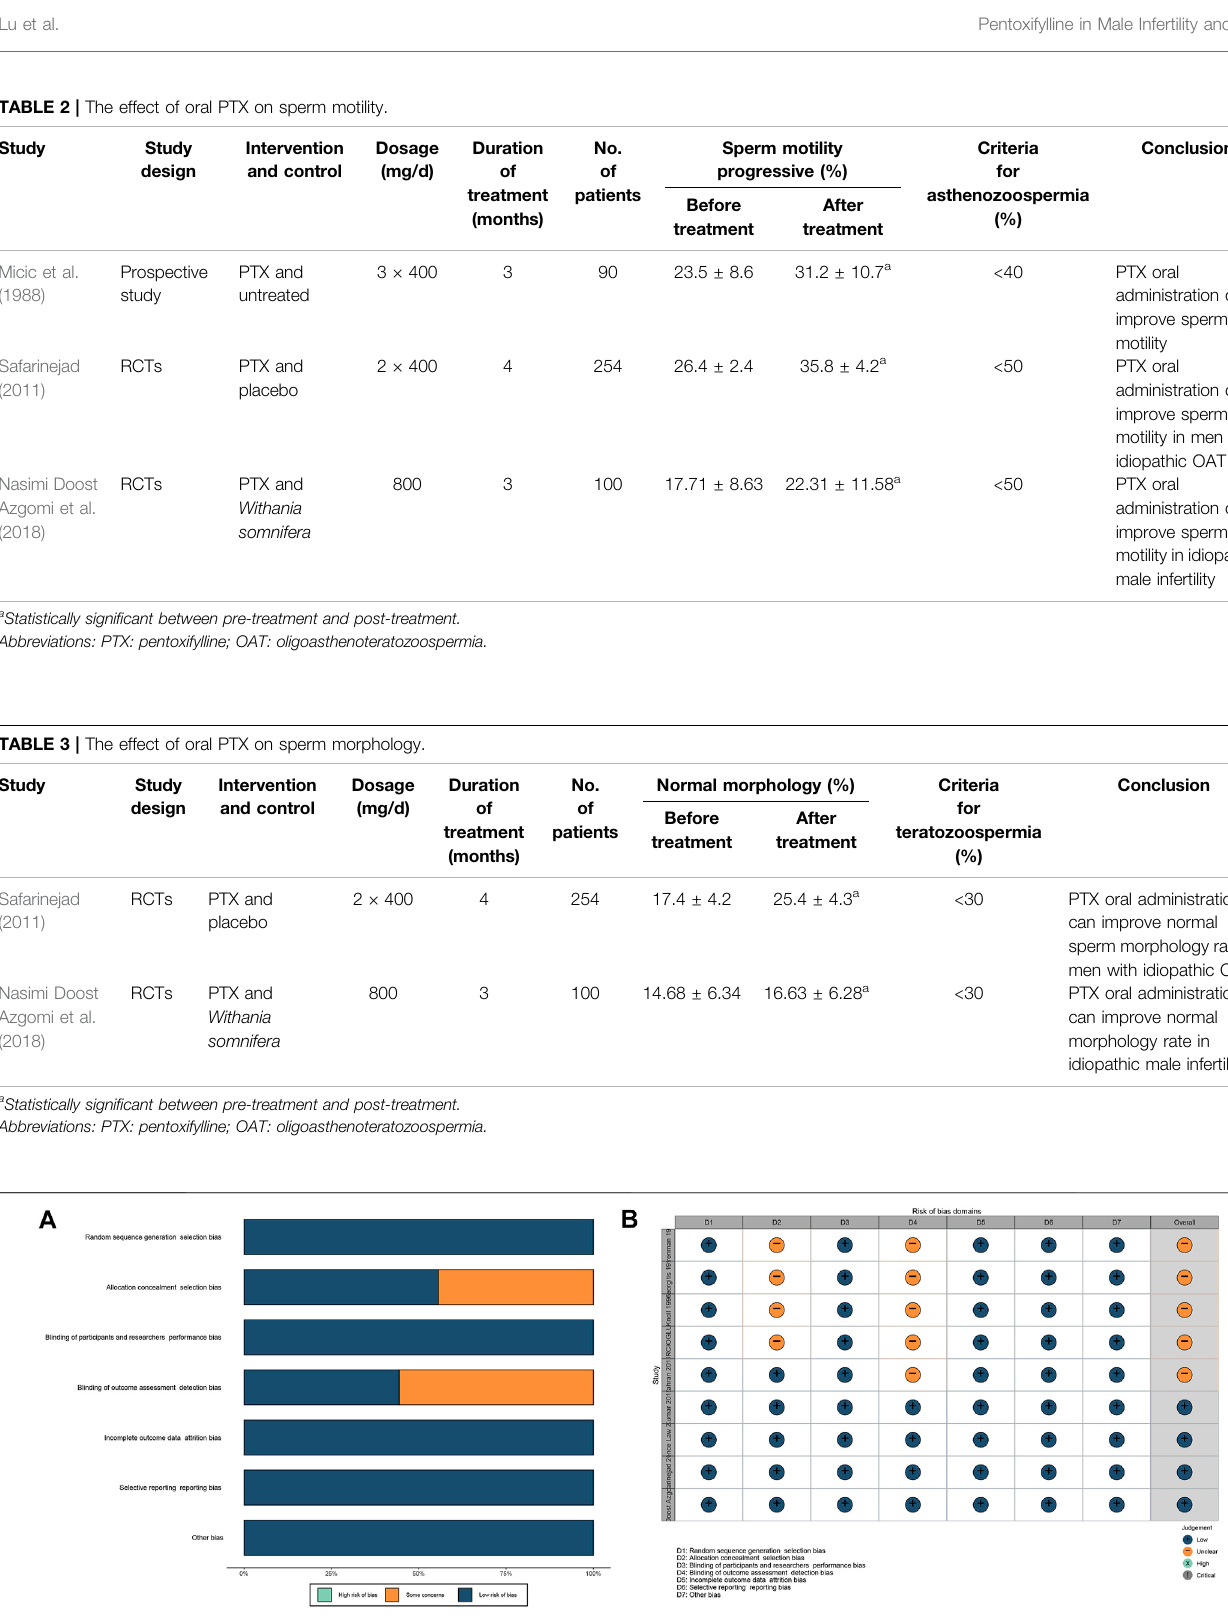
FIGURE 2 | RoB of RCTs. (A) : percentage; (B) : traf fi c light. Abbreviations: RoB: risk of bias; RCT: randomized controlled trial.